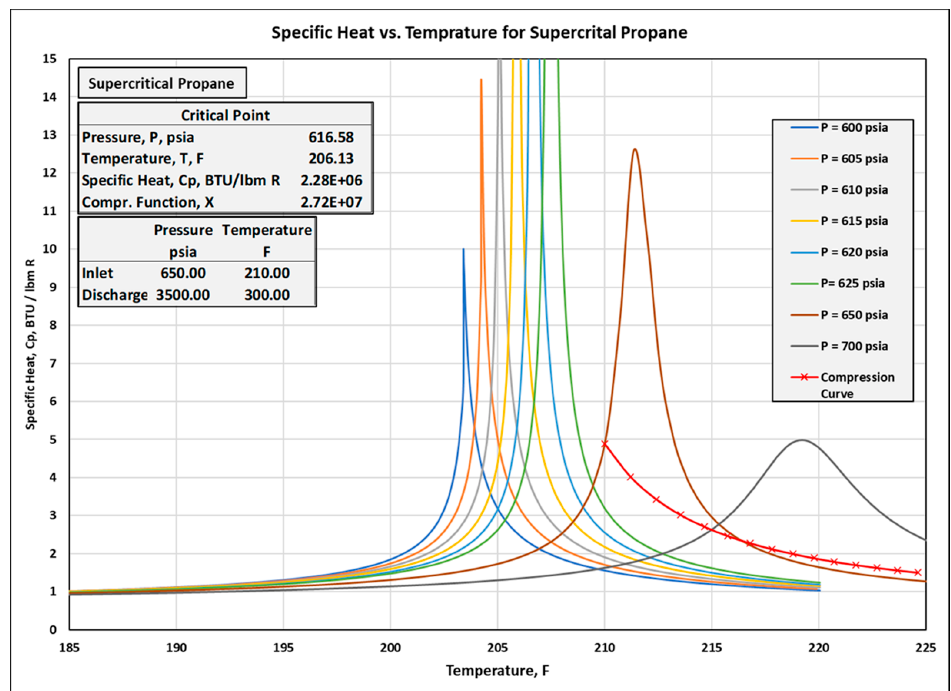
Figure 8. Change of specific heat, c p , along the polytropic path for supercritical propane example. Moreover, the change of specific heat, c p , with temperature at different inlet pressures is